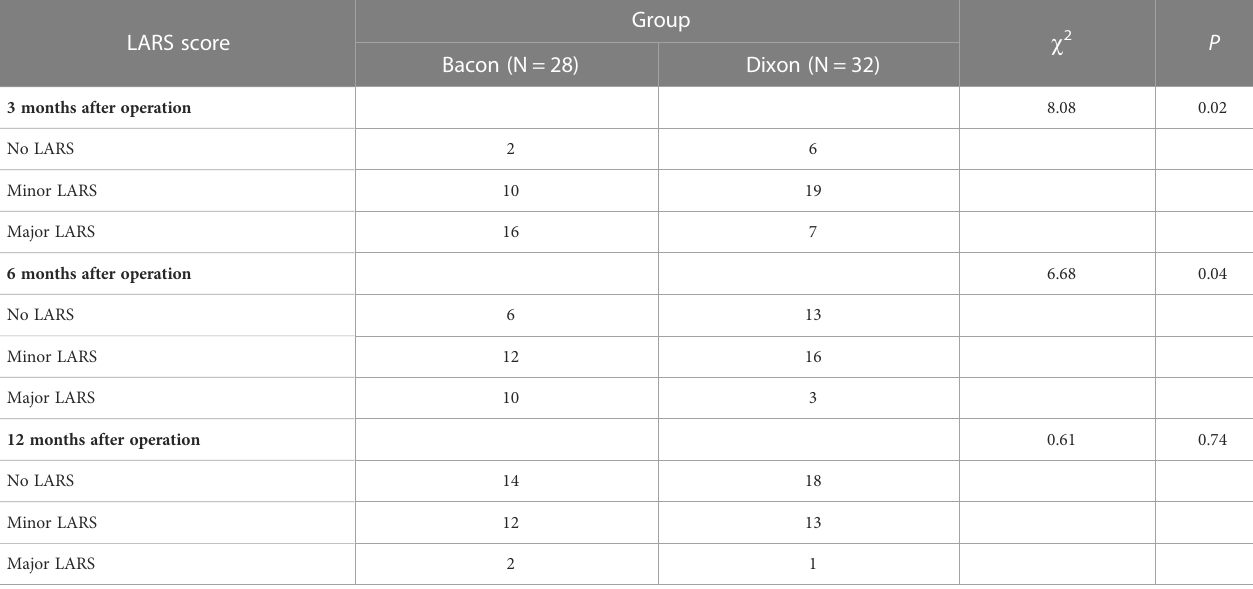
TABLE 5 Postoperative recovery of low anterior resection syndrome in two